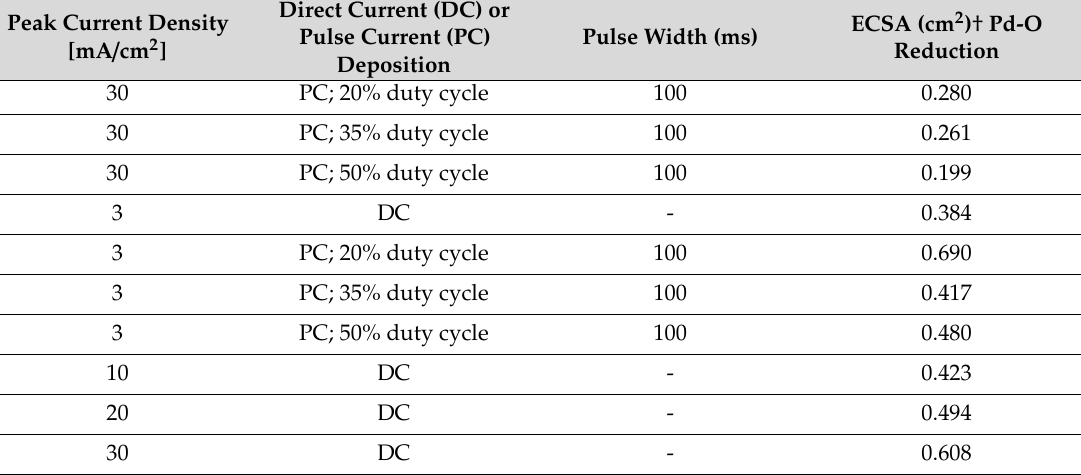
Table 1. Deposition parameters for controlling Pd film